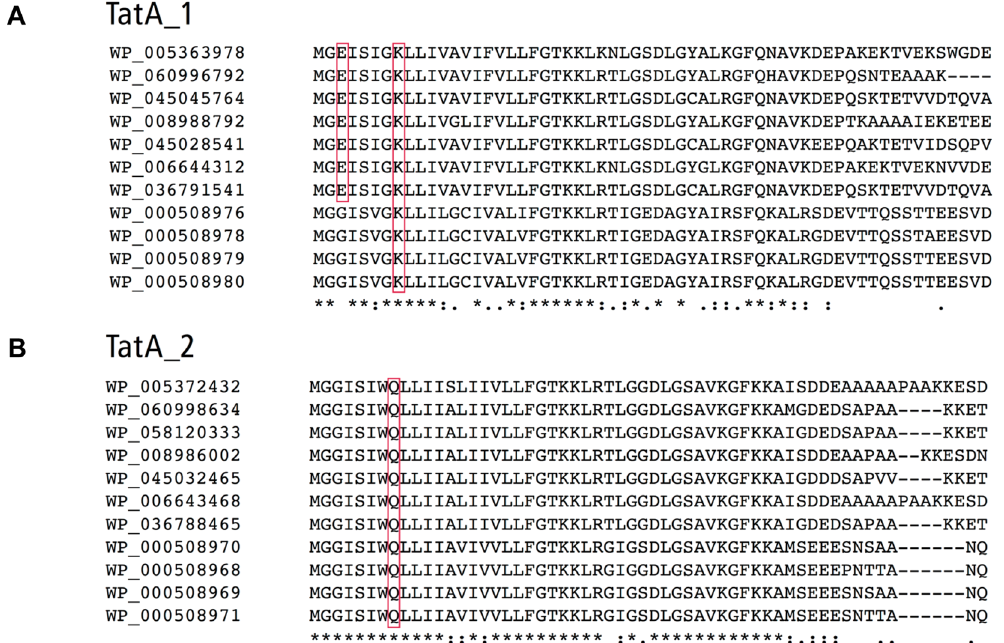
Figure 4. Two distinct TatA orthologs of Vibrionales . TatA_1 paralogs ( A ) feature N-terminal charged residues, which are similar to E. coli TatE (Glu 3 and Lys 8 , boxed), or a single lysine at the 8 th position. TatA_2 paralogs ( B ) carry no charged residues at the corresponding section. The sole polar residue of TatA_2 is Gln 8 , which is conserved in TatA of E. coli . Listed are selected strains of the Order of Vibrionales with the following accession numbers of their TatA_1 and TatA _2 paralogs, respectively: Photobacterium angustum (WP_005363978, WP_005372432); Photobacterium aquimaris (WP_060996792, WP_060998634); Photobacterium kishitanii (WP_045045764, WP_058120333); Photobacterium leiognathi (WP_008988792, WP_008986002); Photobacterium phosphoreum (WP_045028541, WP_045032465); Photobacterium sp. SKA34 (WP_006644312, WP_006643468); Photobacterium (WP_036791541, WP_036788465); Vibrio cholerae (WP_000508976, WP_000508970/WP_000508978, WP_000508968/WP_000508979, WP_000508969/WP_000508980,